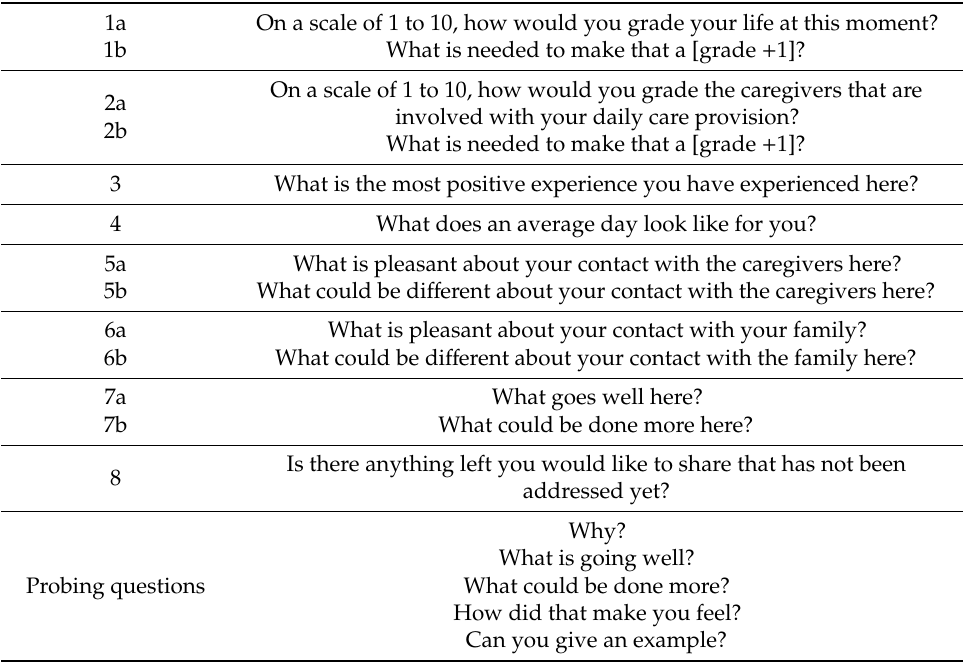
Table A1. Connecting Conversations’